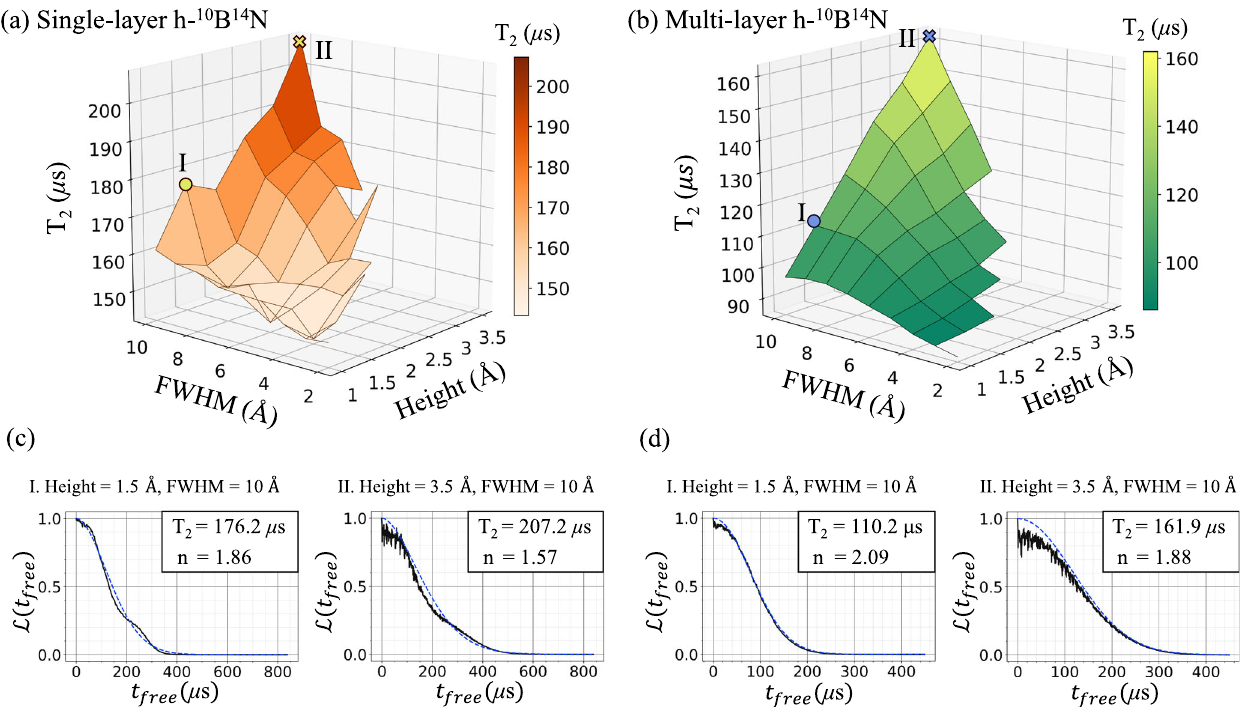
Fig. 6 Maximizing the spin coherence time of V B − by combining isotopic and strain engineering. a , b Computed T 2 of V B − in a single-layer and b multi-layer h- 10 B 14 N, with Gaussian lattice deformation, as a function of FWHM and height of the Gaussian deformation function. Nitrogen in the lattice is 100% 14 N. An external magnetic fi eld of 3 T is applied. c , d V B − spin coherence in c single-layer and d multi-layer h- 10 BN, which has a Gaussian lattice deformation corresponding to condition I (FWHM = 10 Å and height = 1.5 Å) and II (FWHM = 10 Å and height = 3.5 Å) indicated in ( a ) and ( b ),